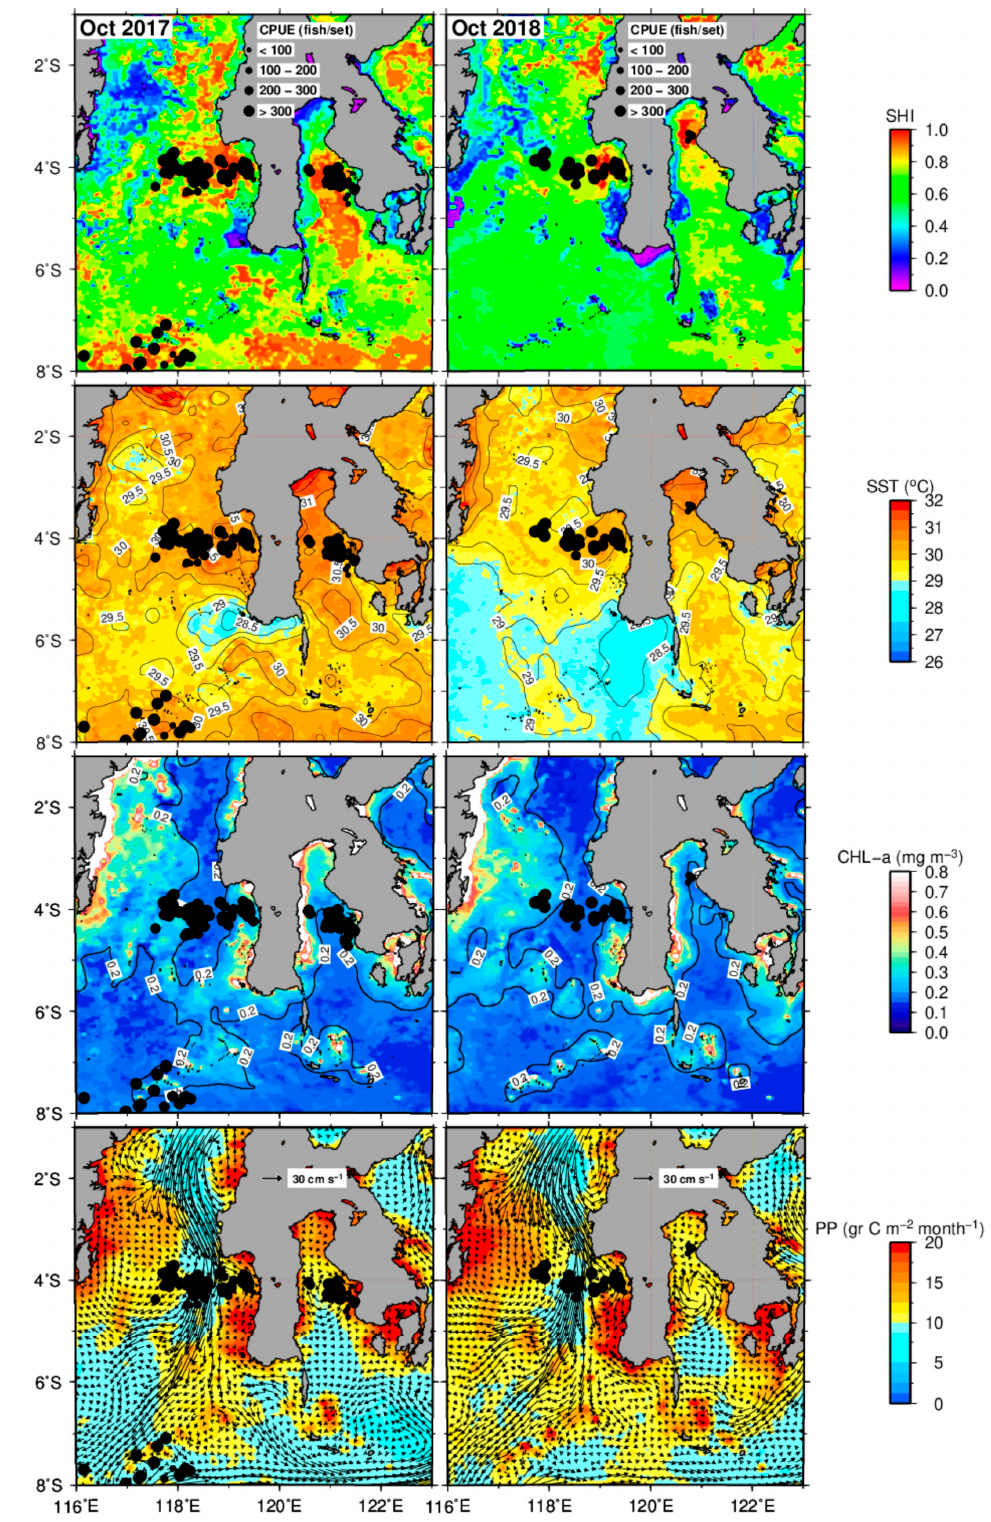
Figure 9. Cross-validation CPUE for skipjack tuna (shown as a black circle) in 2017 ( left panel ) and 2018 ( right panel ) superimposed on predicted habitat hotspots and multiple environmental habitat characteristics.